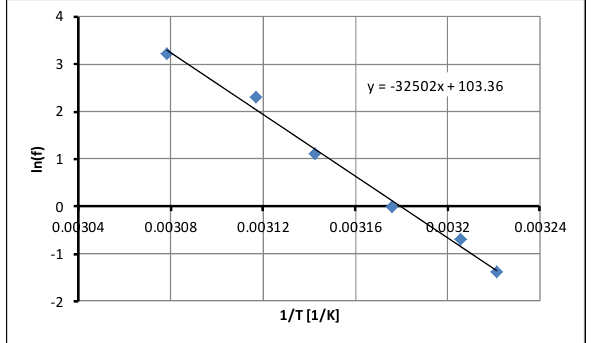
Fig. 16 Evaluation of the DMTA experiments: determination of the activation